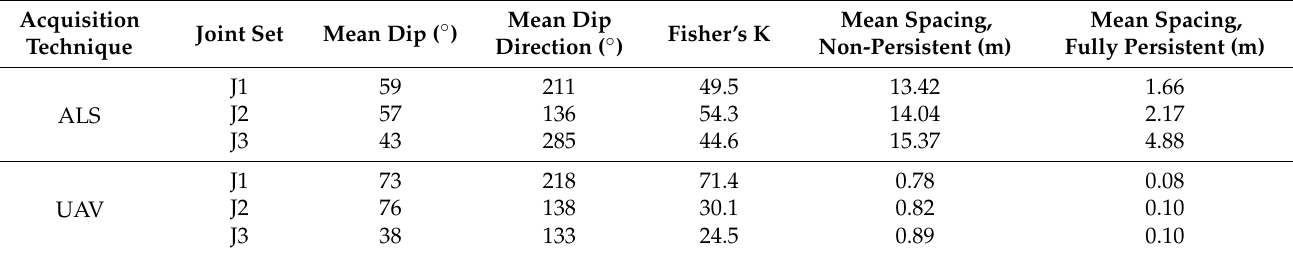
Figure 8. Stereographic projection plot based on set-based mean orientation as poles (lower-hemisphere and equal-area projection). ( a ) Joint sets extracted from ALS points. ( b ) Joint sets extracted from SfM points. Table 4. Summary of the geometrical orientation and spacing of the main joint sets.